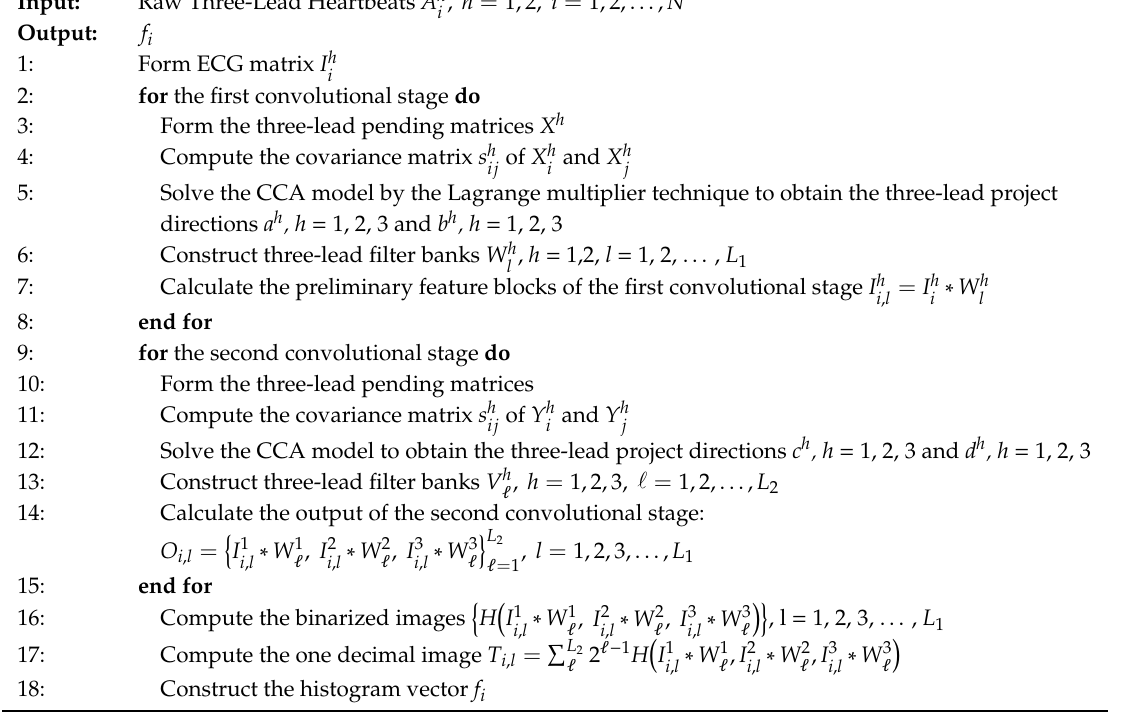
Algorithm 2. The algorithm of two convolutional stages of TL-CCANet.